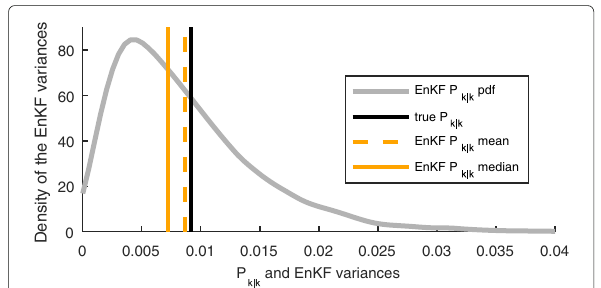
Fig. 1 Distribution of EnKF variances ¯ P k | k with k = 10 and N = 5 ensemble members for 10,000 runs on the same trajectory. Also shown is the mean and median of all outcomes and the desired KF variance P k | k